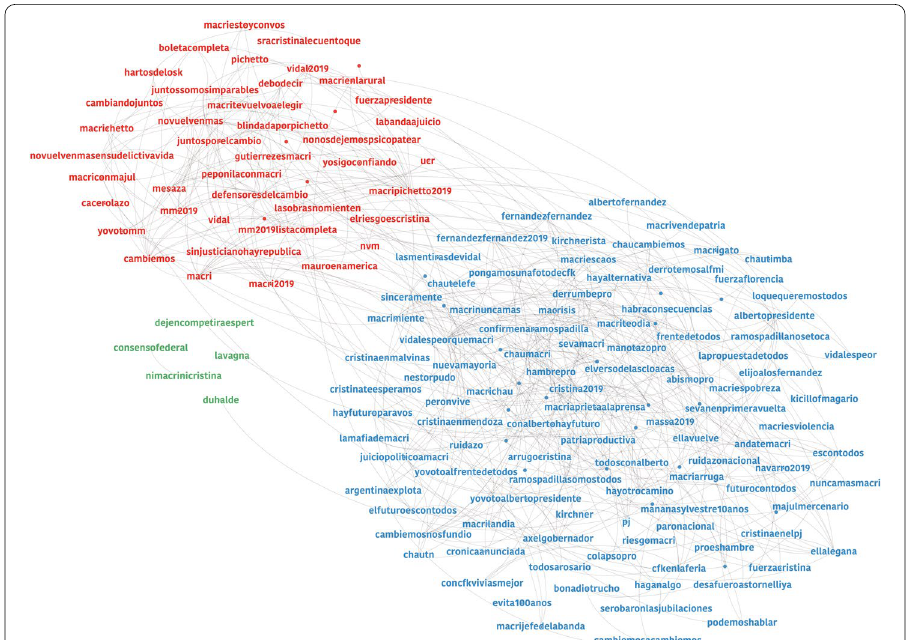
Fig. 7 Hashtag co-occurrence network from March to August 2019. We display in blue the hashtags in favor of Fernández-Fernández, in red the hashtags in favor of Macri-Pichetto and in green those in favor of